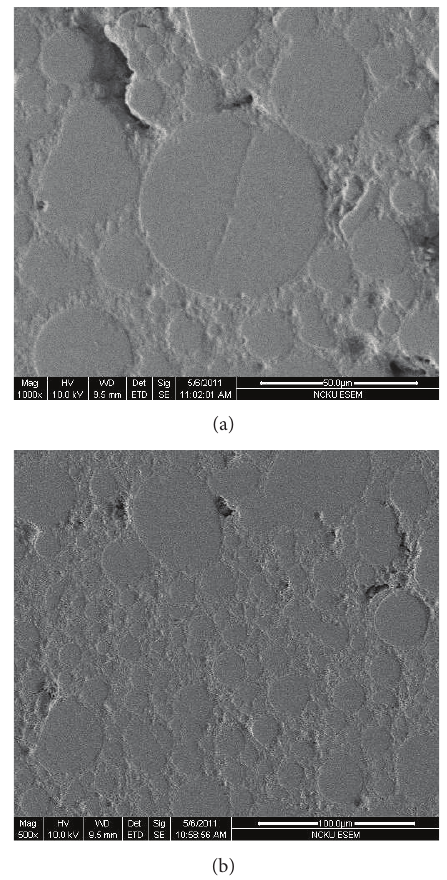
Figure 9: Morphology of organophosphine accelerators-cured epoxy molding compounds: (a) TPP-BQ-cured EMC and (b) TPP- cured EMC,